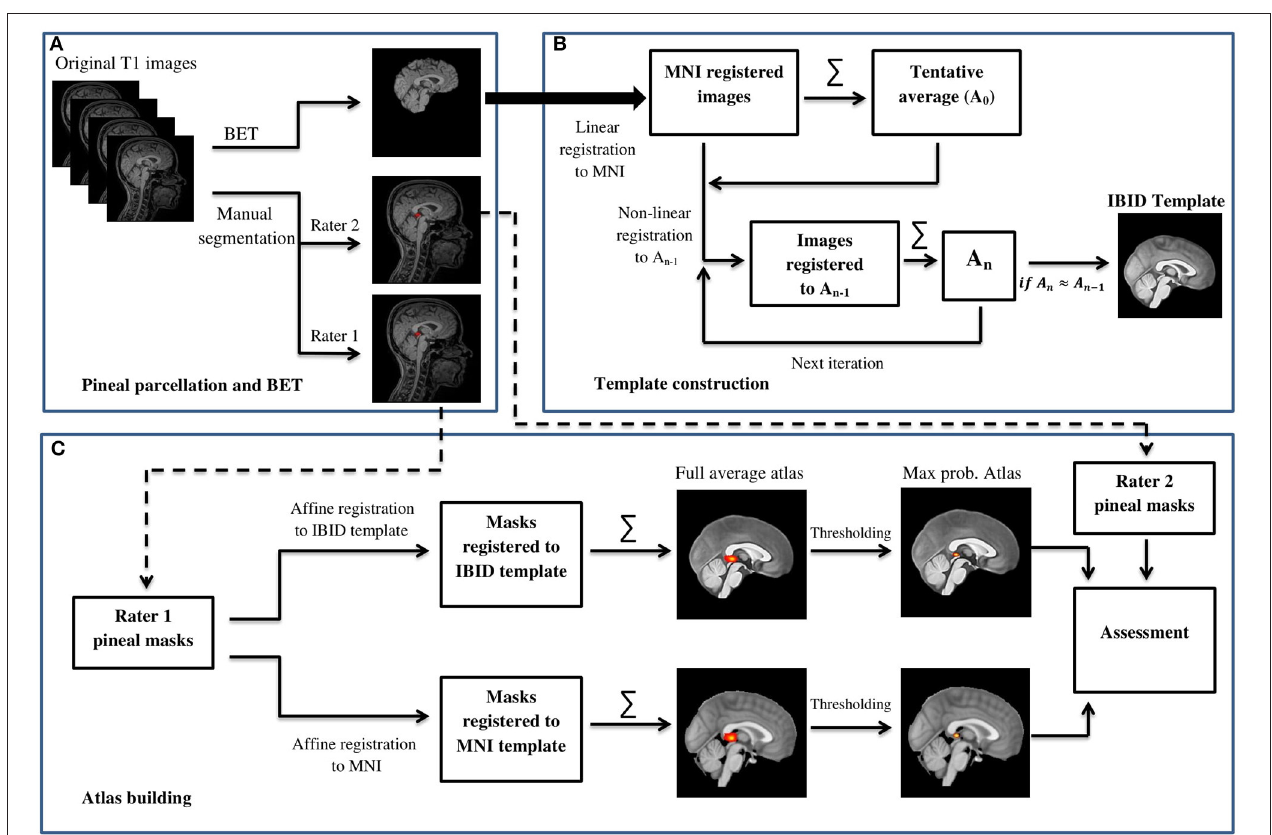
FIGURE 1 | The general flowchart of building the IBID brain template and the pineal gland (PG) atlas. (A) Pineal parcellation and BET. (B) Template construction. (C) Atlas building.